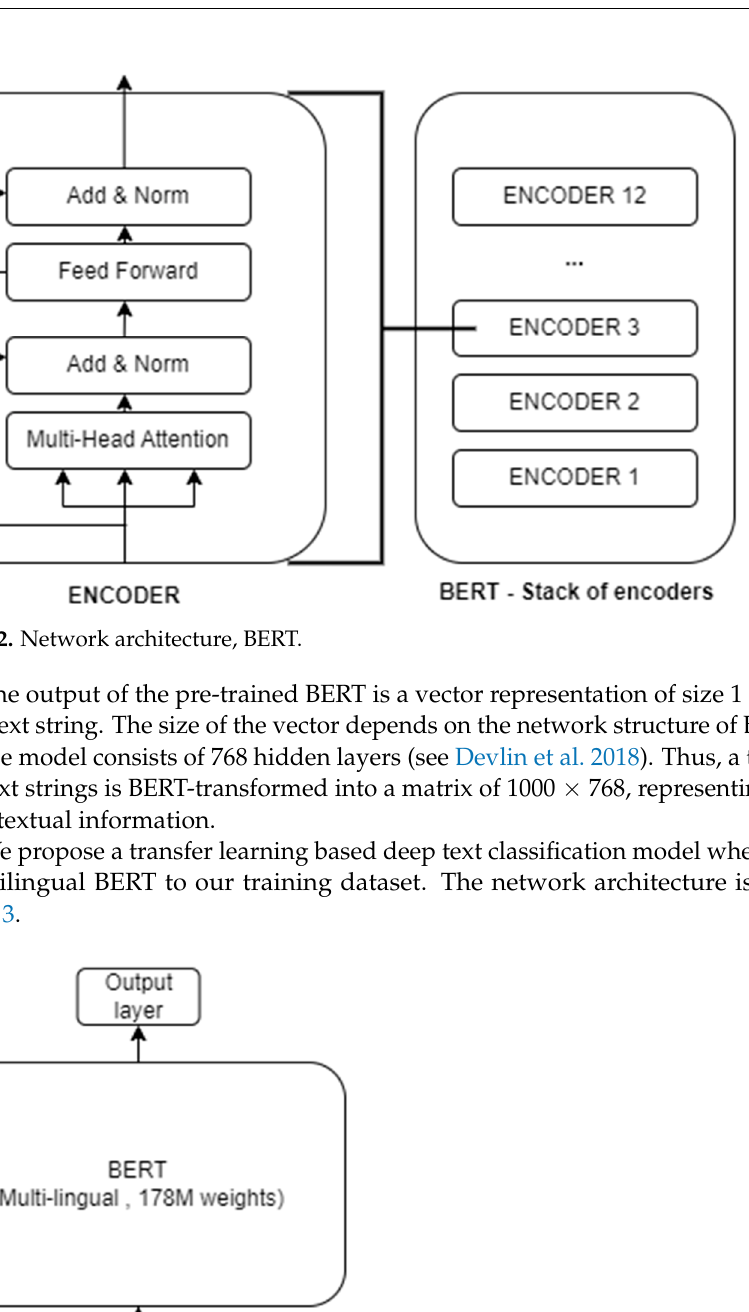
Figure 4. Warmup schedule—learning rate during training. 3.3. SHAP SHAP (Shapley additive explanations), introduced by Lundberg and Lee (2017), is a framework for explaining individual predictions. The SHAP framework is based on Shapley values (Shapley 1953), originally used to calculate fair payouts in games, that is, payouts re fl ecting the players’ contribution to the total payout. Thus, SHAP values assume that the contribution (to the model prediction) of each possible coalition of features should be considered to determine the importance of a single feature. In essence, Shapely values represent the average expected marginal contribution ∅ (cid:3036) of a feature i to the outcome (prediction) after all possible feature combinations have been checked. Here, we think of the text string as a set of players F and the words as embeddings (tokens). For token i , we compute the weighted marginal contribution on all subsets S in F that do not include i . The marginal contribution refers to the change in the output function v caused by the presence of i . Subsets that are close to the initial coalition or the empty set are given higher weights. Formally, the Shapley value of token i is as follows: